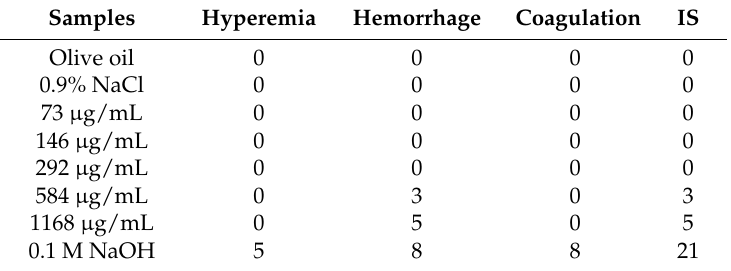
584 µ g/mL 0 1168 µ g/mL 0.1 M NaOH 8